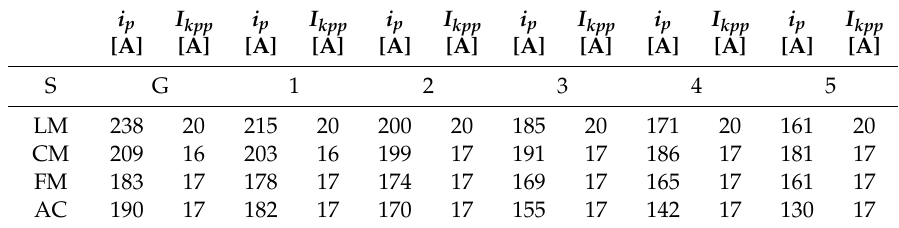
√ (cid:16) (cid:17) 2 2 I k = I kpp